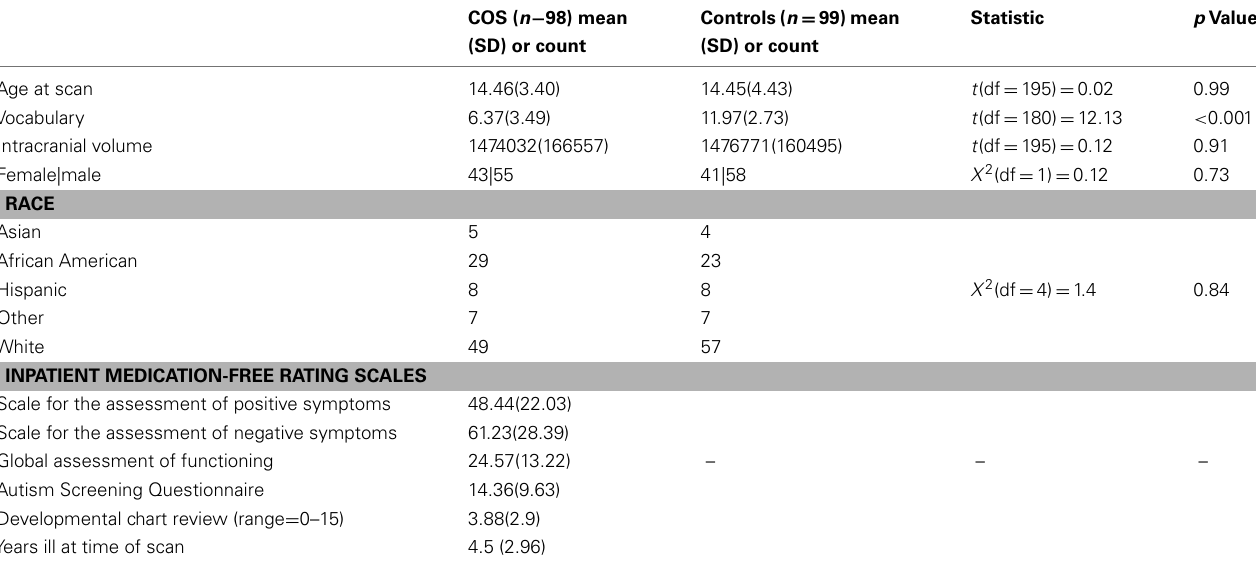
Table 1 | Sample demographics and clinical